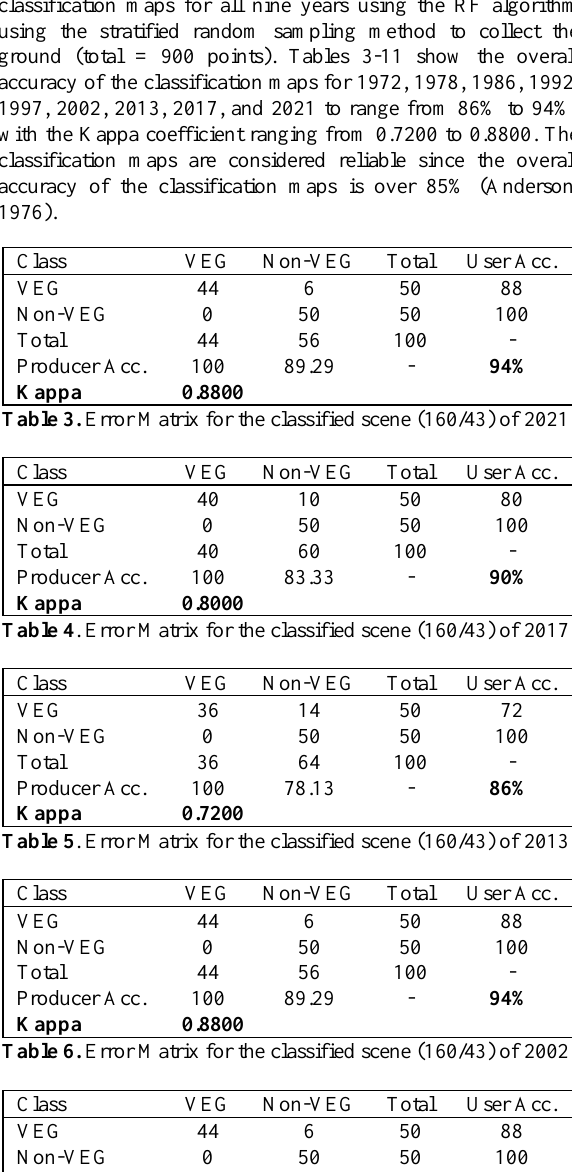
Producer Acc. Table 7. Error Matrix for the classified scene (160/43) of 1997.